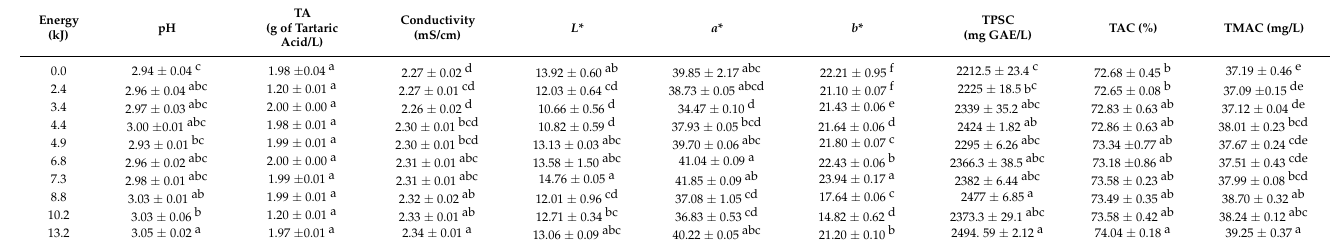
Table 1. Changes in the physicochemical properties of red wine samples treated by pulsed electric fields.